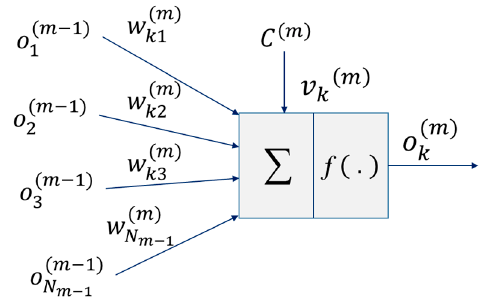
Figure 3. A structure of the k th neuron in the layer m.